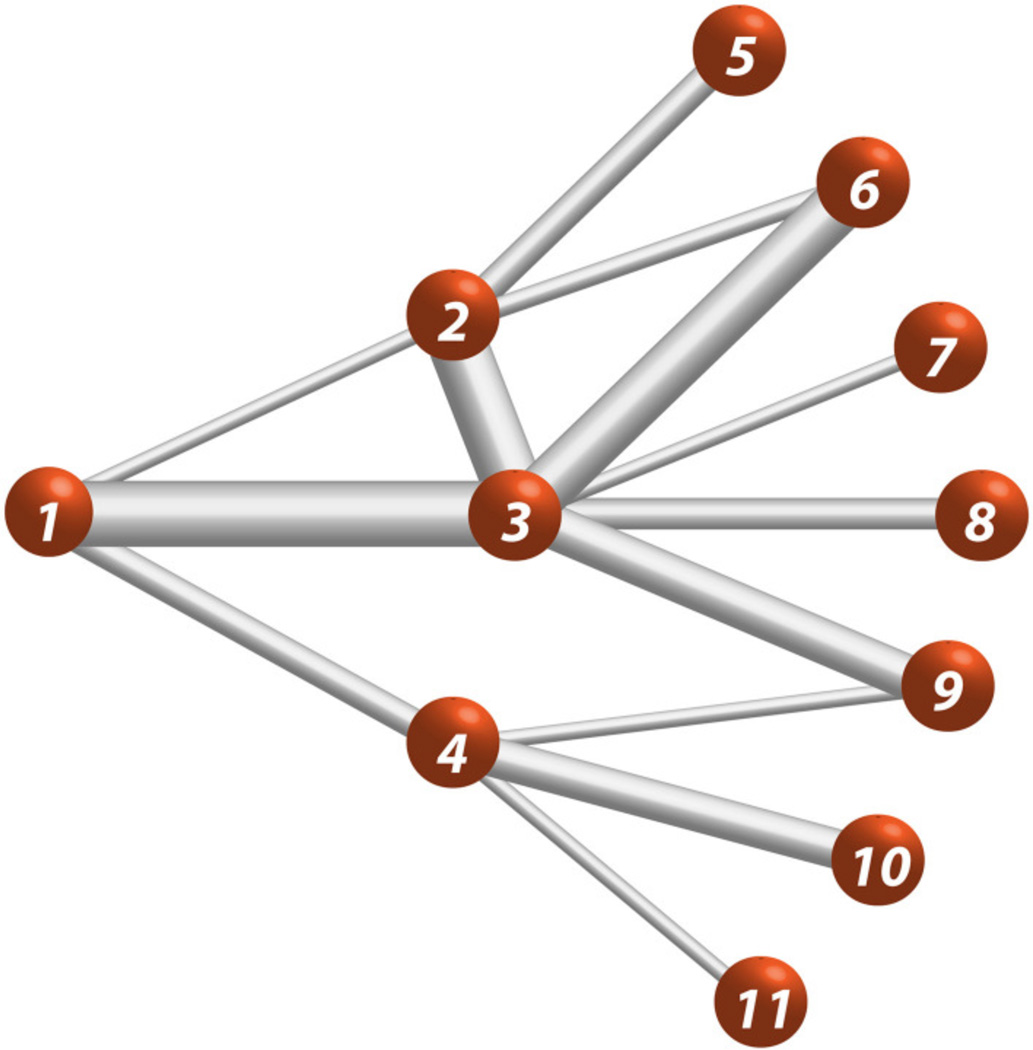
Eleven-node weighted networkEdge thickness represents the relative edge weight strength, e.g., e13 > e14.